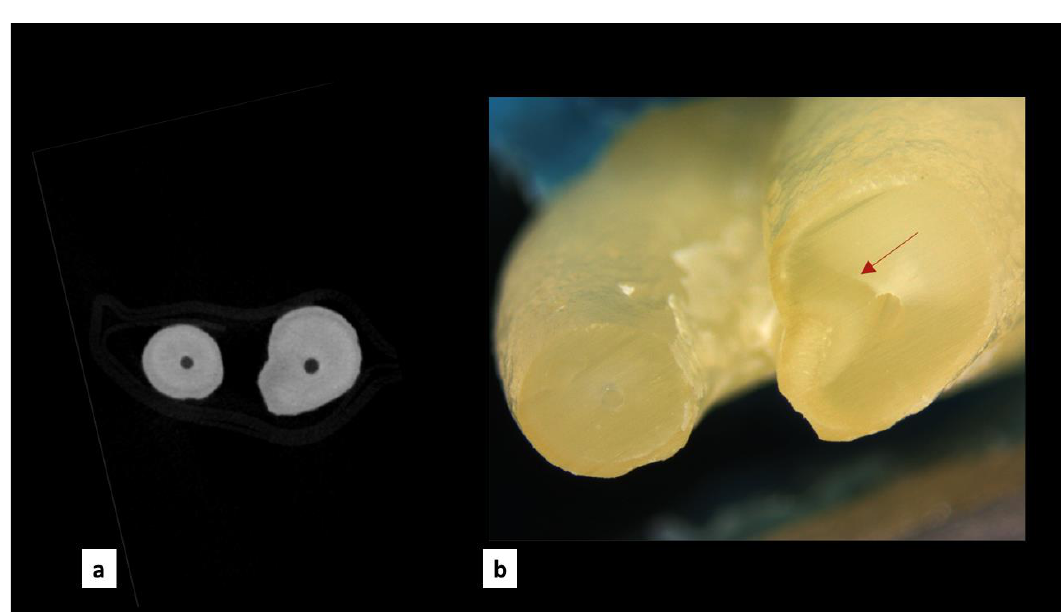
Figure 3. Comparison between the two detection methods. ( a ) Dentinal microcrack observed in the Stereomicroscope image. ( b ) The counterpart Micro-computed tomography (MicroCT) scan, in which the dentinal microcrack is not detectable.